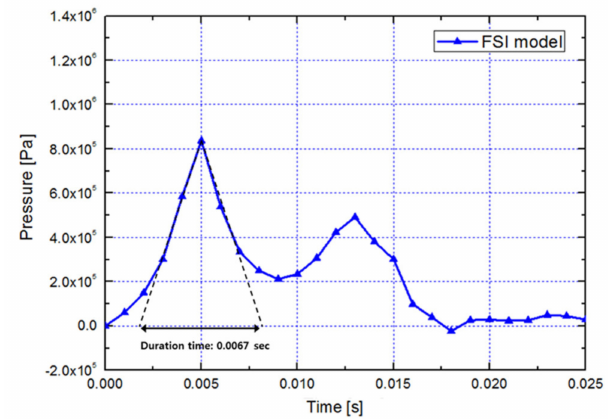
Figure 16. Max. pressure history from the fluid column